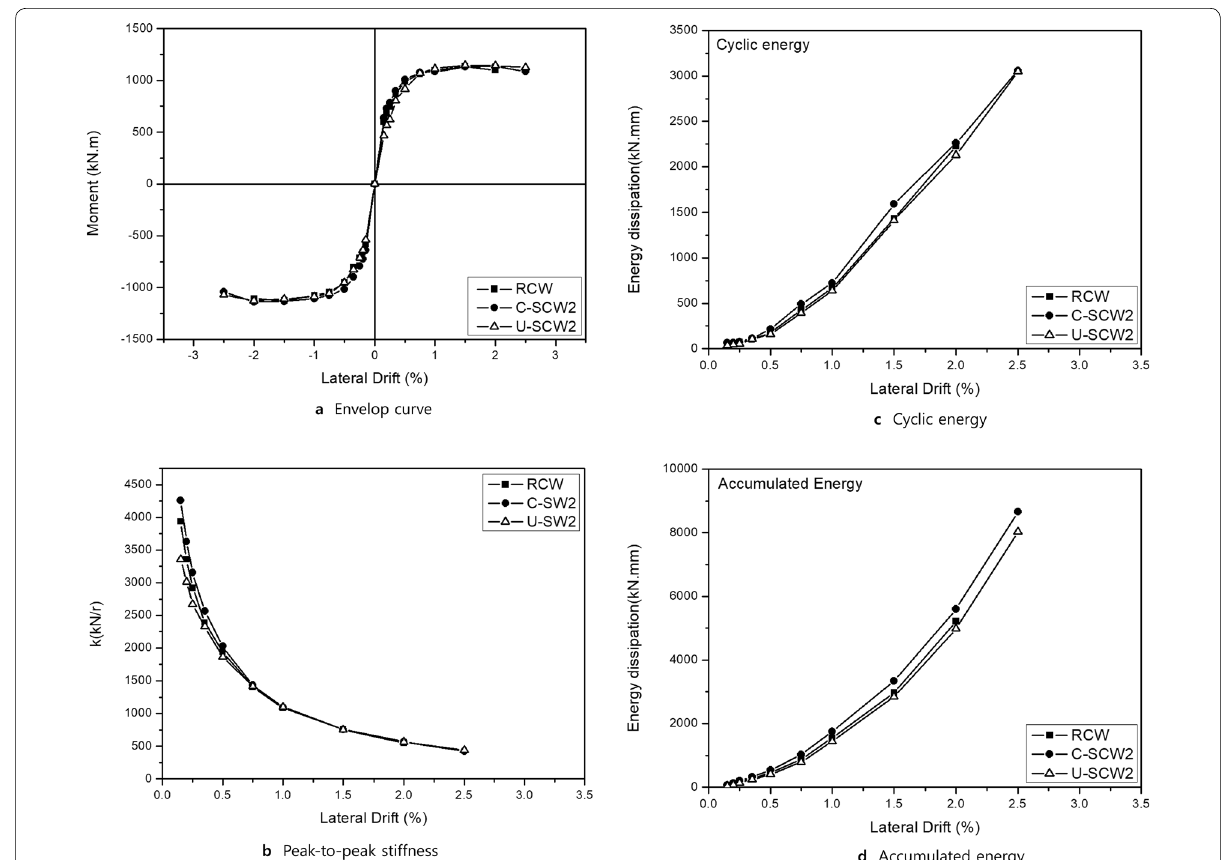
Fig. 14 Comparisons of structural performances for specimens ( P u